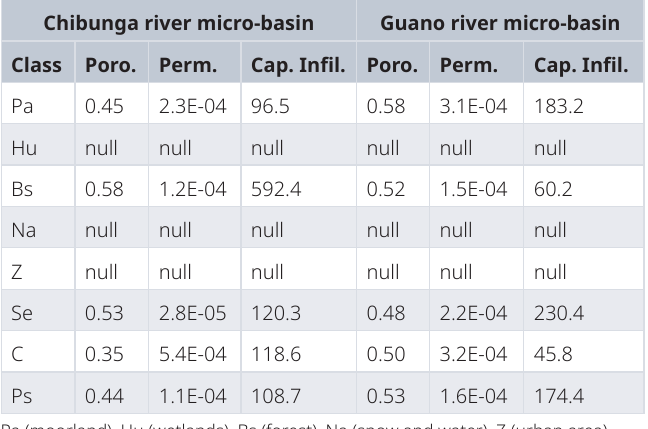
Table 2. Physical characteristics of the soil of the Chibunga and Guano rivers micro-basin.